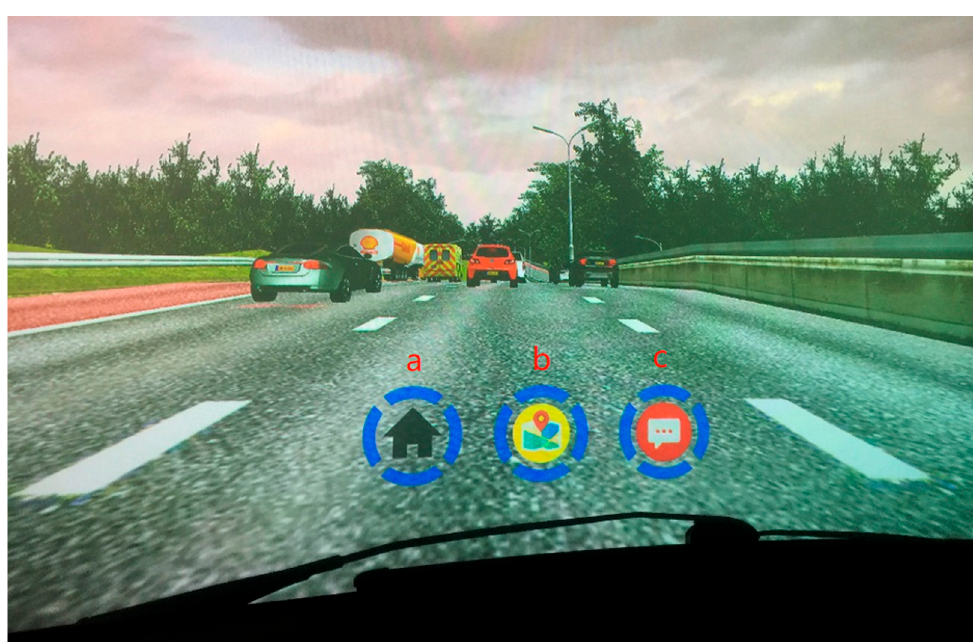
Figure 3. Three main interface symbols as appear in the VR driving simulator: ( a ) Home, ( b ) Navigation/Map, and ( c ) Text Message symbols.